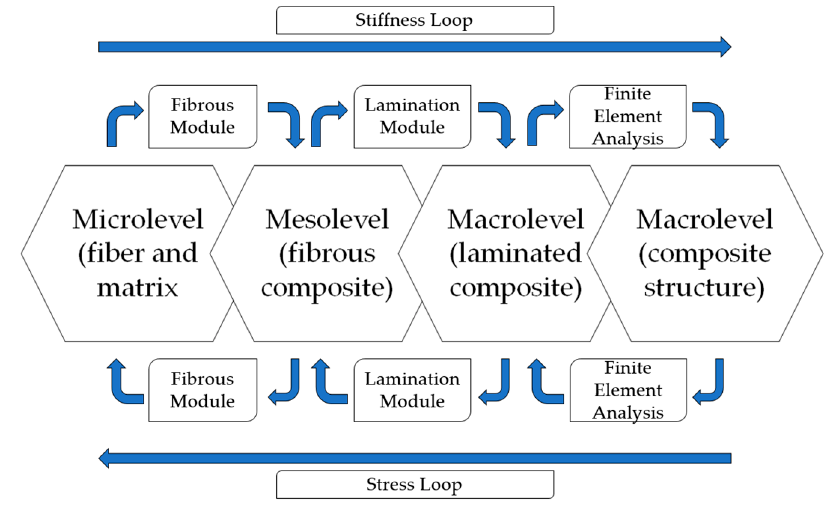
Figure 6. Hierarchy of multiscale analysis for a unidirectional fiber reinforced composite.